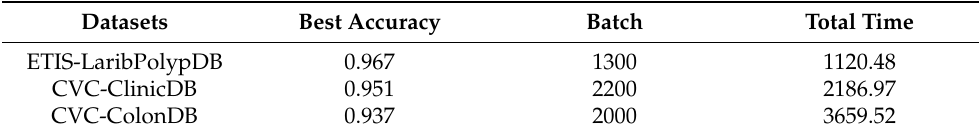
Table 3. The accuracy and the total training time for each